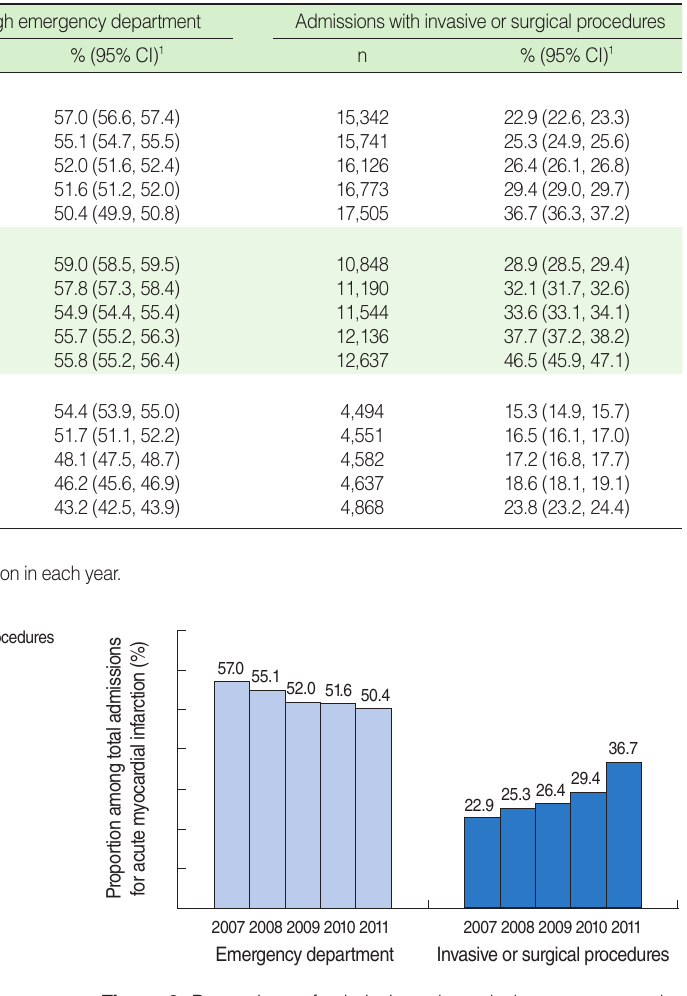
Figure 3. Proportions of admissions through the emergency de­ partment and admissions involving invasive or surgical procedures among total admissions for acute myocardial infarction admissions in each